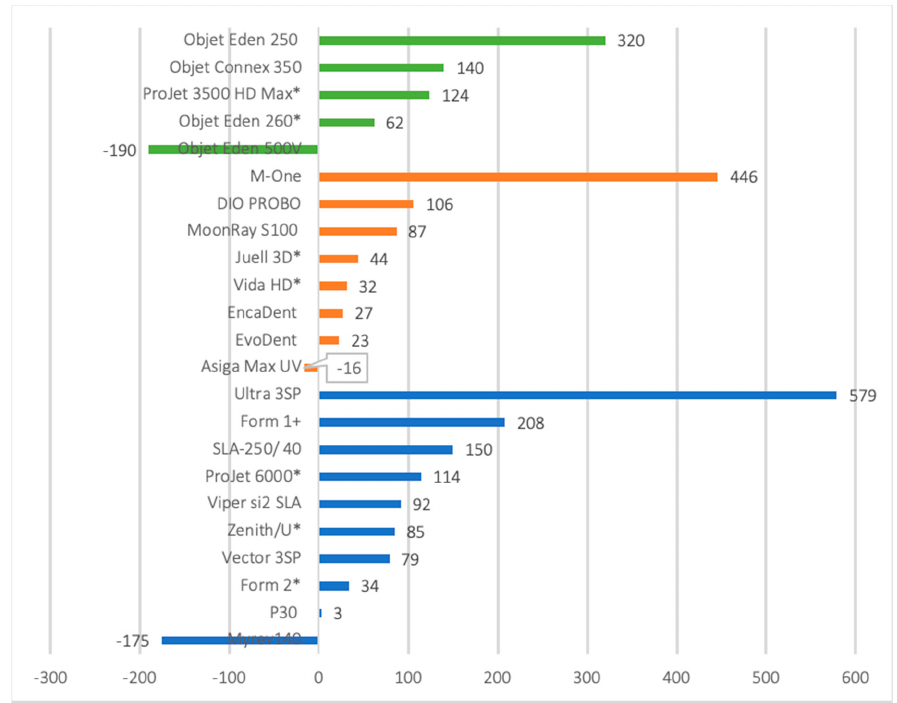
Figure 2. Reported trueness in microns for material jetting (MJ, green), digital light processing (DLP, orange) and stereolithography (SLA, blue) 3D printed full-arch dental models. * Asterisk denotes lowest mean error identified from different studies—other results in microns reported include: Form 2 = 59, 64 and − 80; Zenith series = 138; Projet 6000 = 190; Juell 3D = 44, 70; Vida = 56; Objet Eden 260 series = 74, 80 and 85; Projet 3500 HD Max = 129. Data from studies that did not report details of 3D printer used or trueness data were not included in the figure.